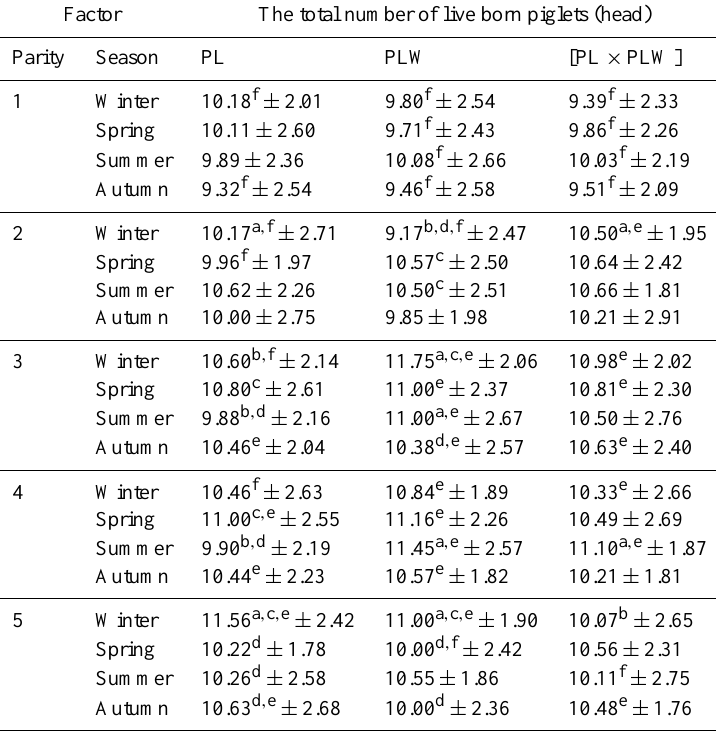
Table 2. The impact of season, parity and breed on the total number of live born piglets. Factor The total number of live born piglets (head) Parity PL